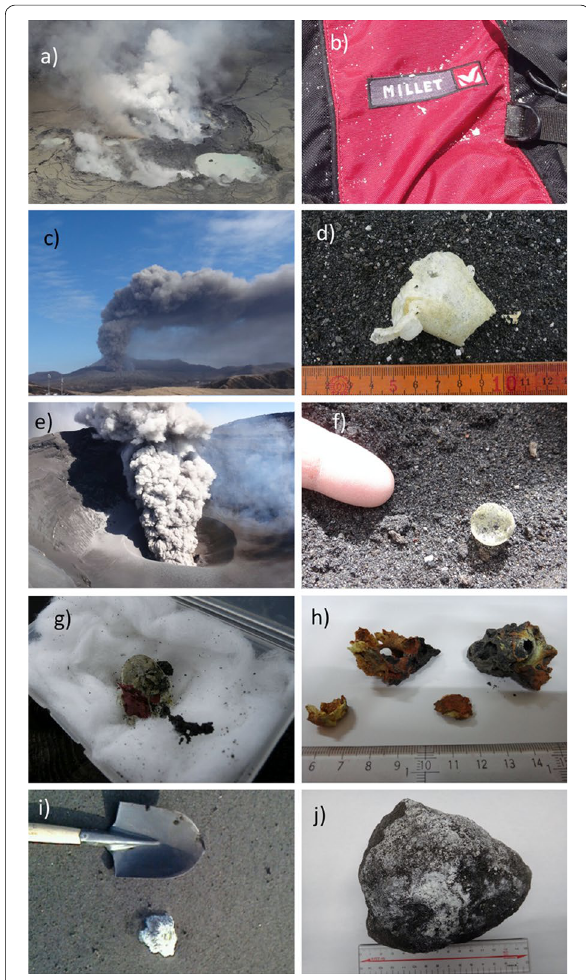
Fig. 1 Photographs of the activities and salt fallouts. a The crater bottom on May 19, 2011. The crater lake is almost dried out, present- ing a brownish plume emitted from a high-temperature vent at the center of the crater bottom. Several other vents also emitted gases intensively. Small amounts of crater lake water remained around the vents. b The salt flakes settled on a backpack on May 19, 2011, at the leeward side of the plume toward the northern rim of the crater. c Ash eruption on January 13, 2015. d A salt shell observed on the ground on January 13, 2015. e The ash eruption on March 17, 2015. f A salt shell fallen from the gas plume 1 h after the temporal cessation of the ash eruption on March 17, 2015. g The salt shells collected on March 17, 2015, and stored in a box. The salts seem to be partly dissolved due to atmospheric moisture and partly recrystallized. h The salt lumps collected on March 26, 2015. i A bomb covered in fine white salts, found on December 27, 2014. j A close-up of the bomb in the laboratory. Most of the salts were fell off during transport because the salts are very